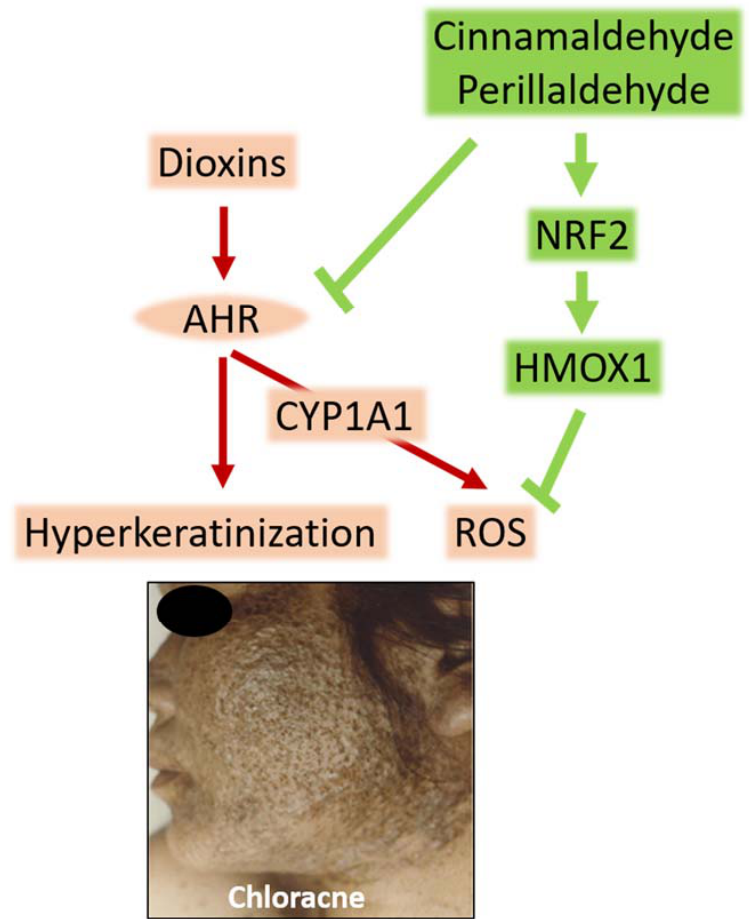
Figure 1. Dioxins activate the aryl hydrocarbon receptor (AHR), upregulate the expression of cytochrome P450 1A1 (CYP1A1), and generate reactive oxygen species (ROS) in keratinocytes and sebocytes. The ligation of AHR by dioxins also accelerates terminal differentiation. Oxidative stress and hyperkeratinization are probably responsible for chloracne. Cinnamaldehyde (a functional component of C. cassia ) and perillaldehyde (a functional component of P. frutescens ) are potent inhibitors of AHR–CYP1A1 signaling. On the other hand, they activate nuclear factor ‐ erythroid 2 ‐ related factor ‐ 2 (NRF2). NRF2 is a master switch for the cellular antioxidative system. The activation of NRF2 upregulates various antioxidative enzymes, such as heme oxygenase ‐ 1 (HMOX1), and neutralizes ROS. These natural phytochemicals are useful for managing chloracne.